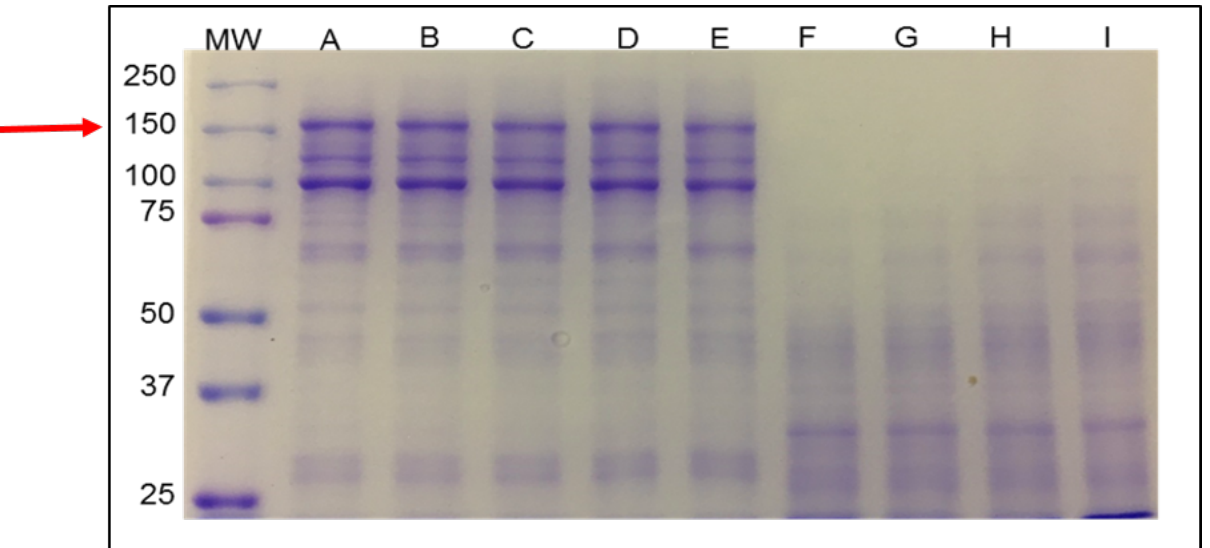
Figure 1. SDS-PAGE under non-reducing conditions (7.5% polyacrylamide gel, Mini Protean II System, Bio-Rad) of (A) native TeNT and TeNT irradiated with (B) 1 kGy, (C) 2 kGy, (D) 3 kGy, (E) 4 kGy, (F) 5 kGy, (G) 6 kGy, (H) 7 kGy and (I) 8 kGy. (MW) Molecular mass markers (Precision Plus Protein TM Standards